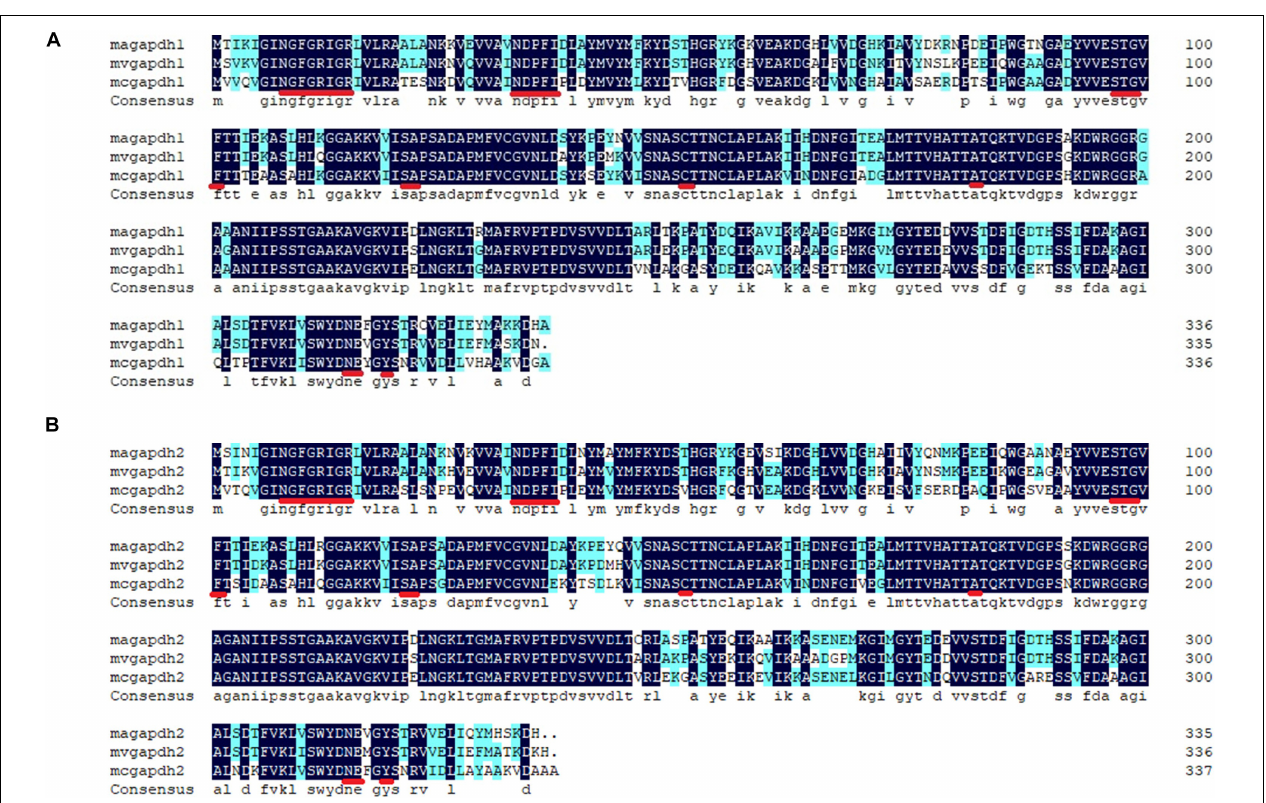
FIGURE 1 | Alignments of the predicted genes with verified genes of other species. (A) alignments of GAPDH1; (B) alignments of GAPDH2. The alignments were carried out by the software DNAman. Sequence of other GAPDH amino acids were downloaded from website of NCBI. Magapdh1, Mortierella alpina ATCC32222, GI: MN417267; mvgapdh1, Mortierella verticillata NRRL6337, GI: 672823544; mcgapdh1, Mucor circinelloides f. circinelloides 1006PhL, GI: 511008895; magapdh2, M. alpina ATCC32222, GI: MN417268; mvgapdh2, Mortierella verticillata NRRL6337, GI: 672823261; mcgapdh2, Mucor circinelloides f. circinelloides 1006PhL, GI: 511007306.